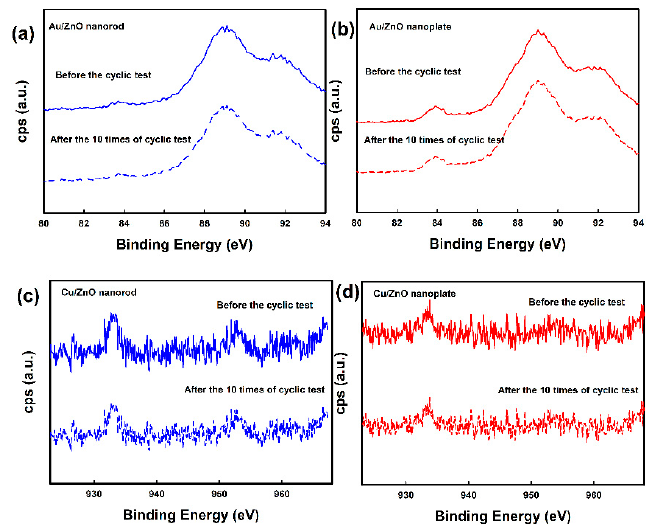
Figure 10. The chemical states of metal deposited ZnO structures before and after the stability test: ( a ) Au 4f spectra of Au/ZnO nanorod, ( b ) Au 4f spectra of Au/ZnO nanoplate, ( c ) Cu 2p spectra of Cu/ZnO nanorod, and ( d ) Cu 2p spectra of Cu/ZnO nanoplate.